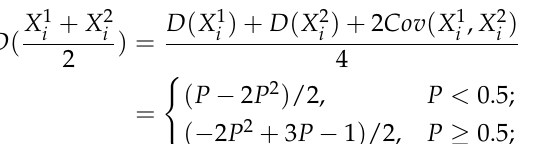
and X 2 , i = 1,2,..., N i i